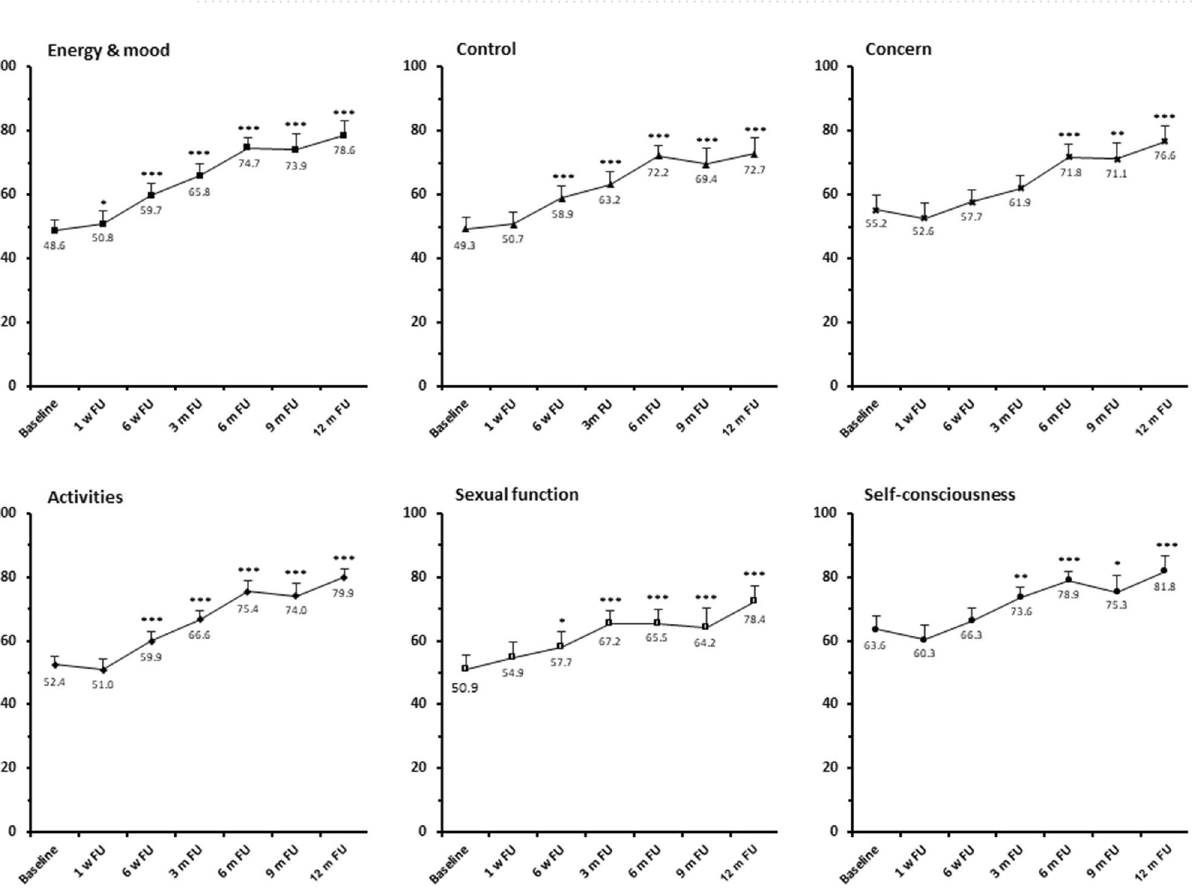
Figure 5. Mean scores of the subscales of Health-Related Quality of Life (HRQOL) after HIFU ablation of uterine fibroids are presented. Significance levels are indicated by the stars attached (* p < 0.05, ** p < 0.01, *** p < 0.001) next to average scores. Standard errors were symmetrical (only positive error bars are shown). The average postinterventional scores indicate a significant treatment-associated improvement of all QOL subcales (energy&mood, control, concern, activites, sexual function, self-consciousness). FU Follow-up, m month, w week.